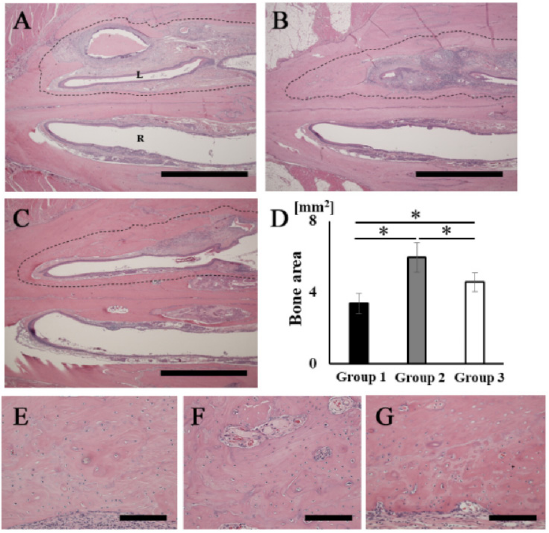
Figure 5. Histological analysis of rat palatine fissures. The horizontal plane section (stained with H&E at 16 weeks after grafting) is shown. ( A , E ) Group 1. ( B , F ) Group 2. ( C , G ) Group 3. ( D ) New bone tissue area (dashed line area) in groups 1, 2 and 3. Newly formed bone areas in bone defects measured using ImageJ software at 16 weeks after grafting. ( A – C ) Overview of rat palatine fissure. Scale bars represent 2 mm. ( E – G ) Higher magnification of the new bone tissue area in ( A – C ), respectively. Scale bars represent 150 µ m. L: The left palatine fissure (implantation side). R: The right palatine fissure (normal side). * p < 0.05. The results are shown as means, with error bars representing the standard deviation ( n = 15). Materials 2021 , 14 , x FOR PEER REVIEW